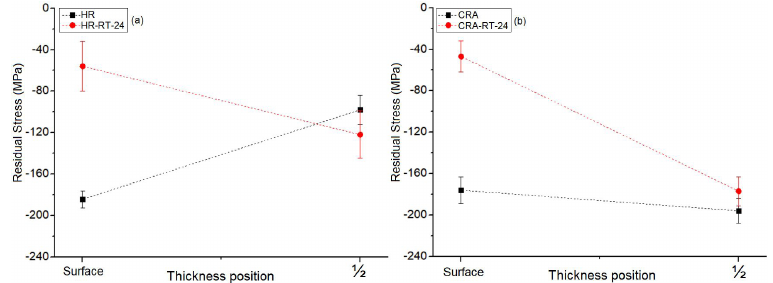
Figure 6. Comparison on the residual stresses of the austenite phase between (a) HR and (b) CRA samples, both in as-received condition and after 24% deformed in tensile test at room temperature.